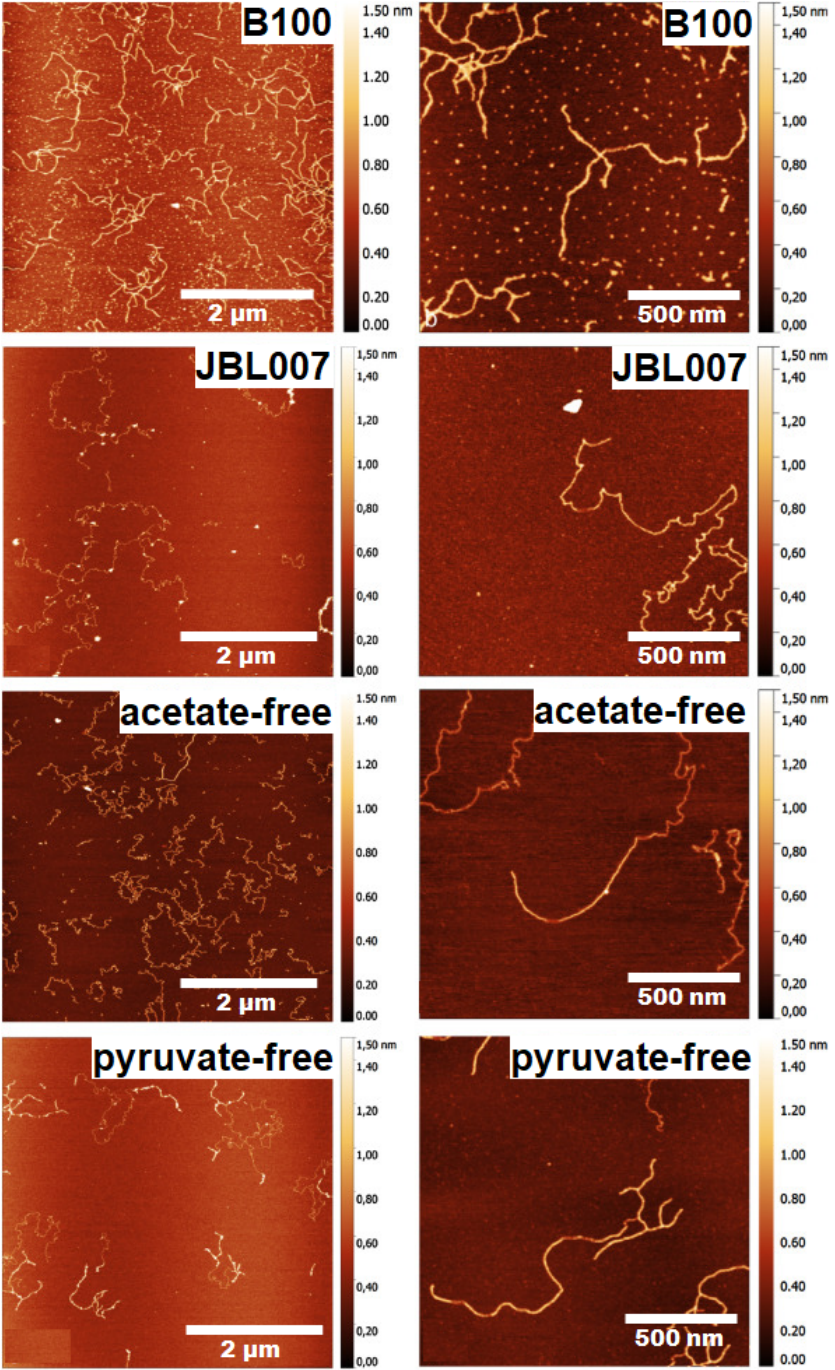
Figure 14. AFM topographical images of xanthan from different sources. Images left provide the overview while right show the detailed structure of the samples [77] (Reprinted with permission from Teckentrup et al., 2017.)